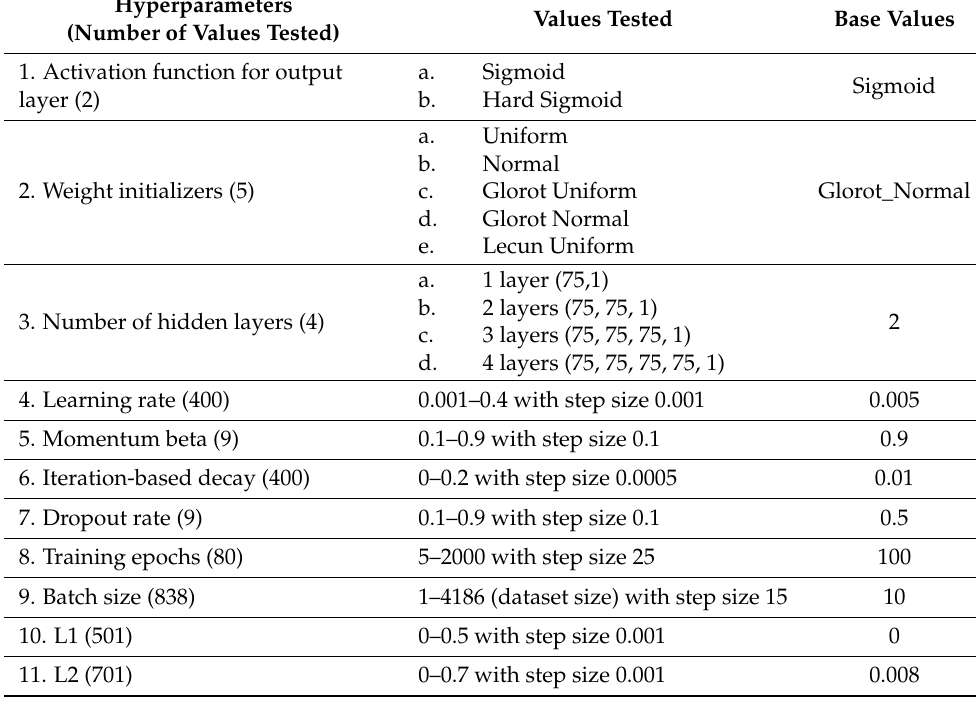
Table 1. Hyperparameters and their values in grid